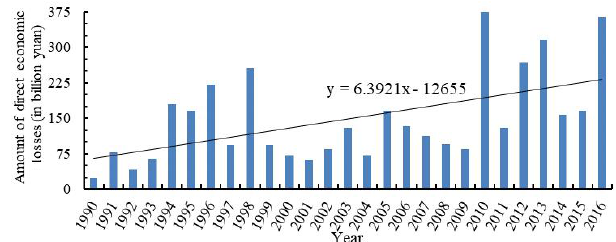
Figure 2. Number of deaths caused by flood from 1980–2016 (MWR, 2007–2016).